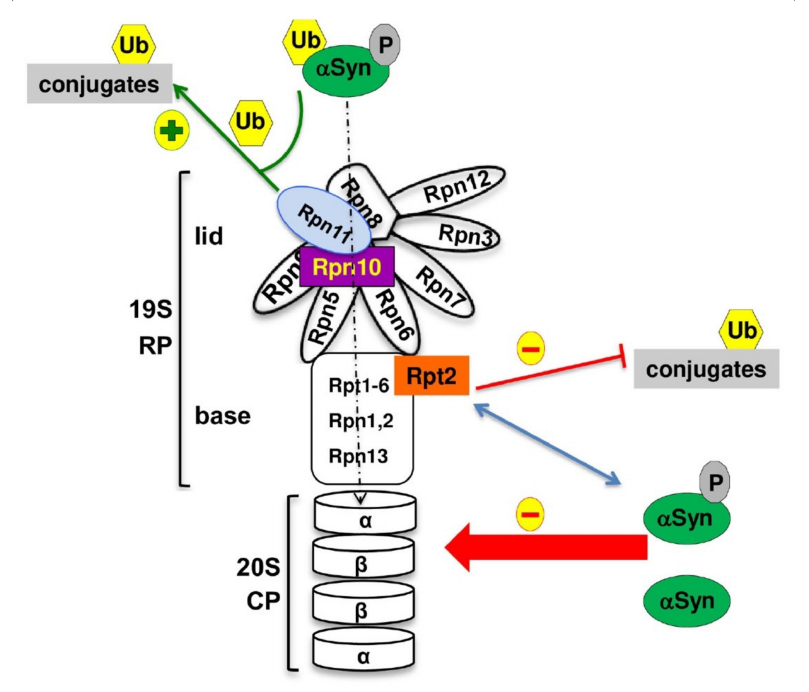
Figure 10. α Syn expression significantly reduces the proteasome pool. Model of the 26S proteasome consisting of a 19S regulatory particle (RP) and 20S core particle (CP). Ubiquitinated (Ub) substrates associate with the proteasome mediated by the RP subunits Rpn10 and Rpn13. The deubiquitinating enzyme Rpn11, which is part of the lid, removes polyubiquitin chains from the substrates to further promote their degradation. Phosphorylation at S129 promotes turnover of soluble α Syn by the proteasome. The base subunit Rpt2 promotes opening of the entry pore of the 20S CP, which enables protein substrates to be translocated into the catalytic channel for degradation. Regulation of CP–RP interactions is essential for substrate-specific proteasome degradation function. Phosphorylated α Syn is in proximity to the Rpt2 base subunit, which presumably causes proteasome dysfunction and an altered pool of ubiquitin conjugates. α Syn significantly reduces the abundance of the proteasome subunits, which could be due to 26S disassembly and subsequent degradation of the proteasome